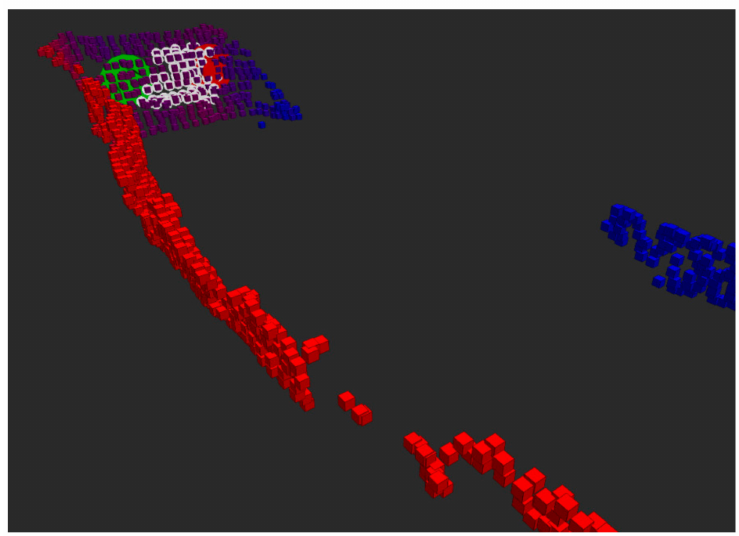
Figure 10. Point cloud showing pile reconstruction (point color corresponds to the ny component of the